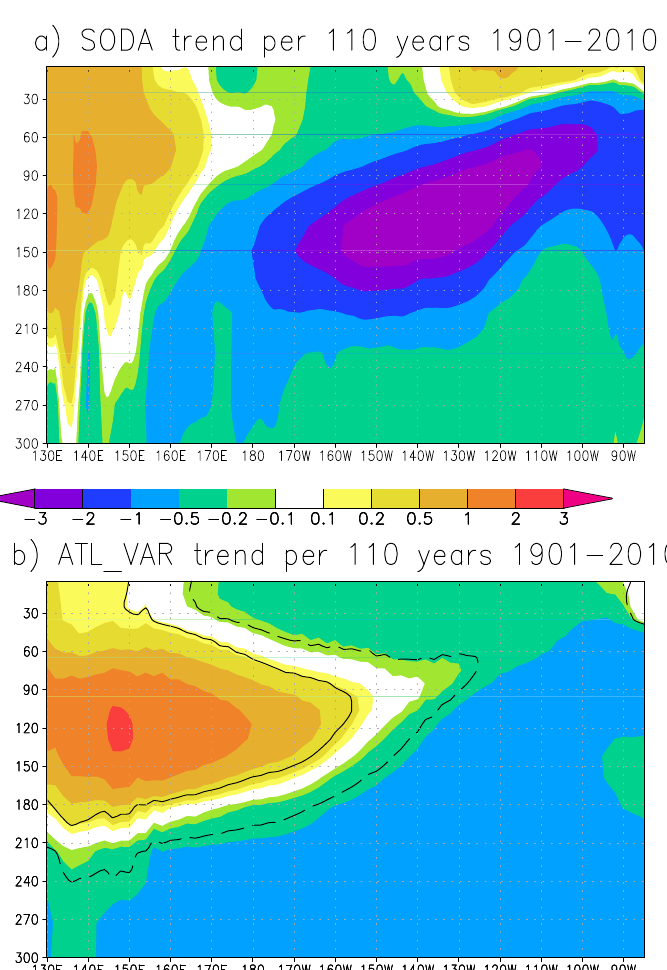
Figure 16. Linear trend of temperature near the equator (averaged from 5 ◦ S to 5 ◦ N) for the period 1901 to 2010 per 110 years for ( a ) observed and ( b ) ATL_VAR. In ( b ), anomalies that are 95% statistically significant are indicated by contours. Units are